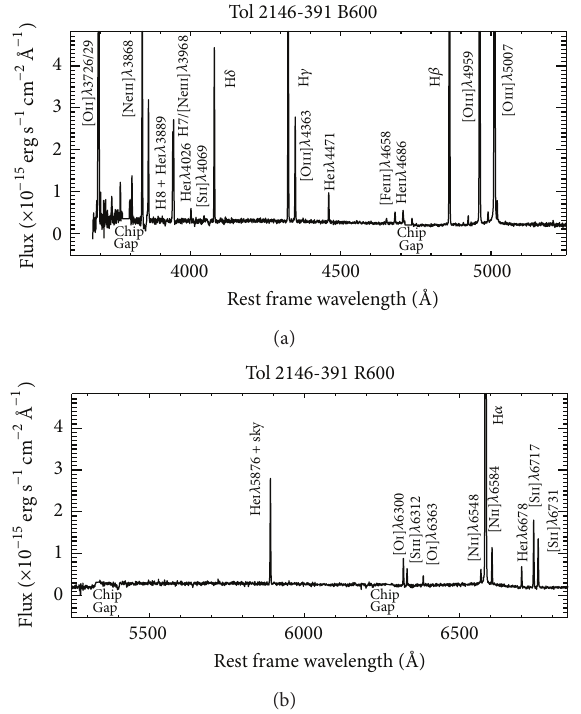
Figure 1: Integrated spectra of the H ii/BCD galaxy Tol 2146- 391. Top panel: blue spectrum (grating B600). Bottom panel: red spectrum (grating